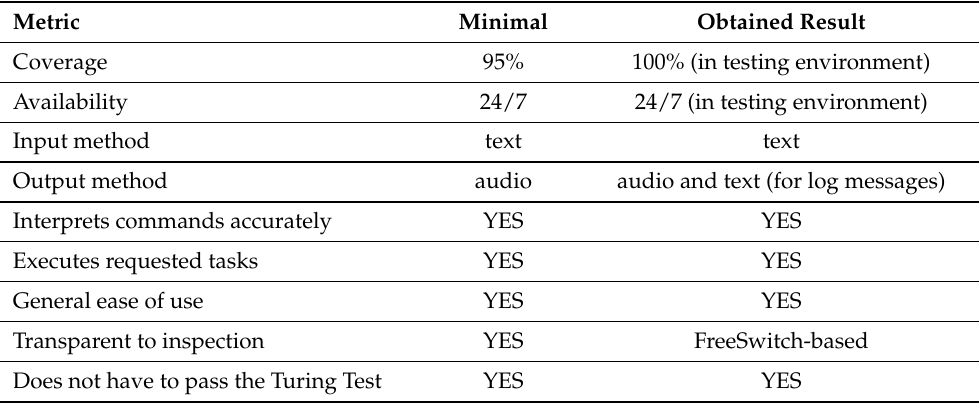
Table 5. Summary of effectiveness